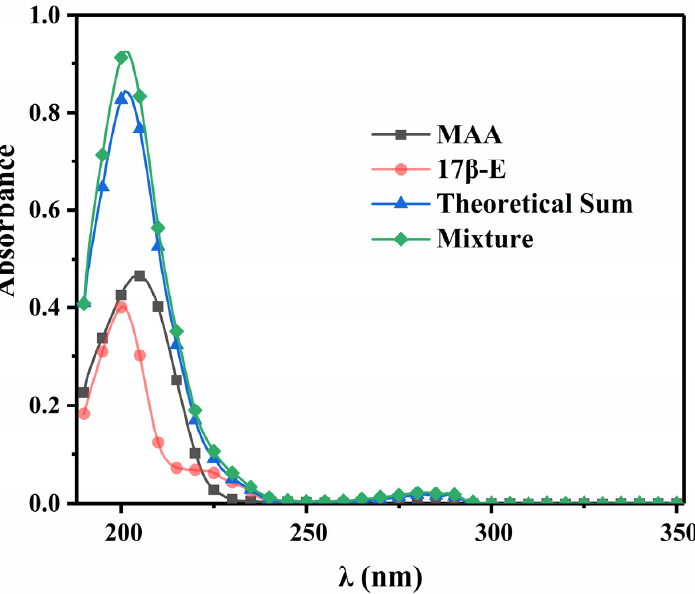
Figure 1. Ultraviolet absorption spectra of E2, MAA, and mixture of E2 and MAA in acetonitrile solution.